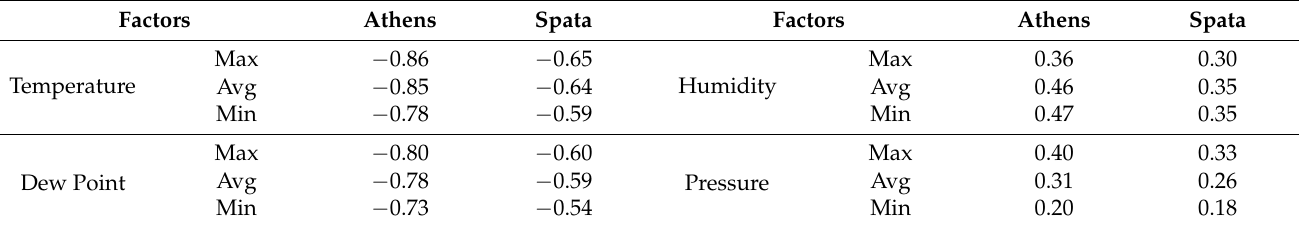
Table 2. Pearson correlation coefficient between climate profile and